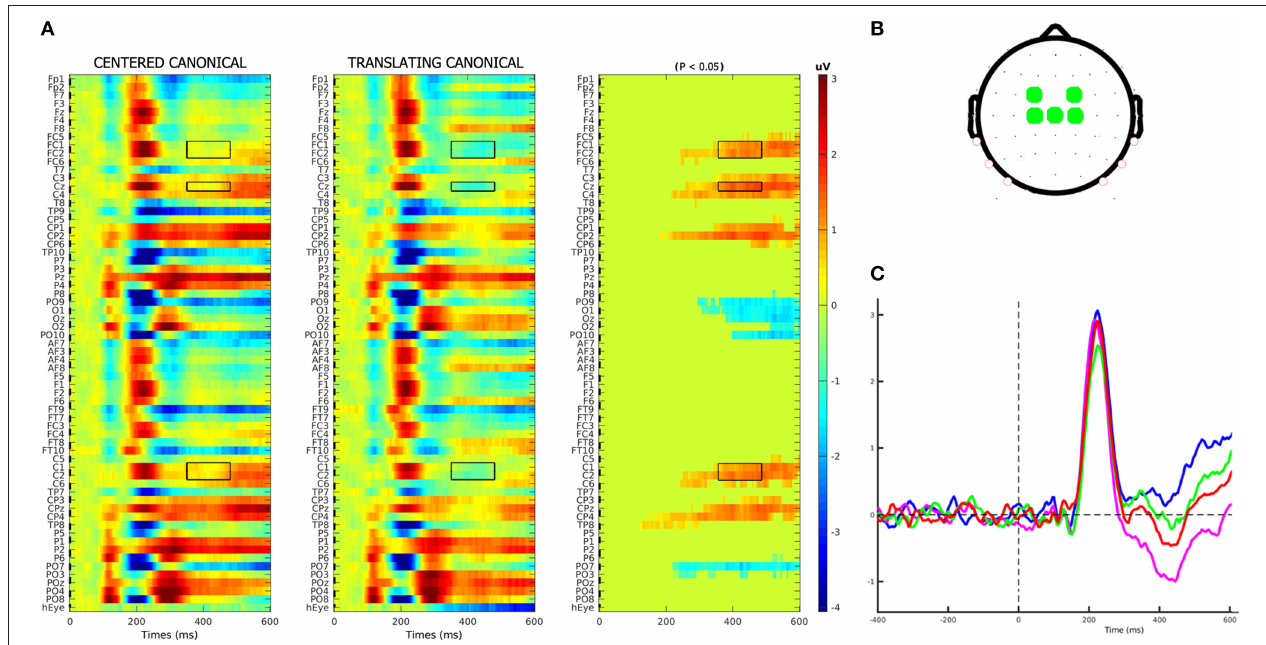
FIGURE 3 | N2c component identification. (A) Results of cluster-based permutation analysis of the CC–TC conditions’ contrast. In first two columns, the two conditions’ group-averages are displayed. In the third column, we represent their amplitude differences (in µ V), in those channels-latencies pairs where a significant ( p < 0.05) difference was found. In accordance with the scalp topography observed for TC condition, the electrodes cluster used to model the negative N2c component was composed by those electrodes that had negative (blue) values in TC condition and positive (red) in CC ones. Selected electrodes-latencies were marked by a black rectangle. (B) Fronto-central electrodes, defined according to the above criteria, used to compose the N2c cluster. (C) Plot of the N2c cluster’s group-average in each condition.